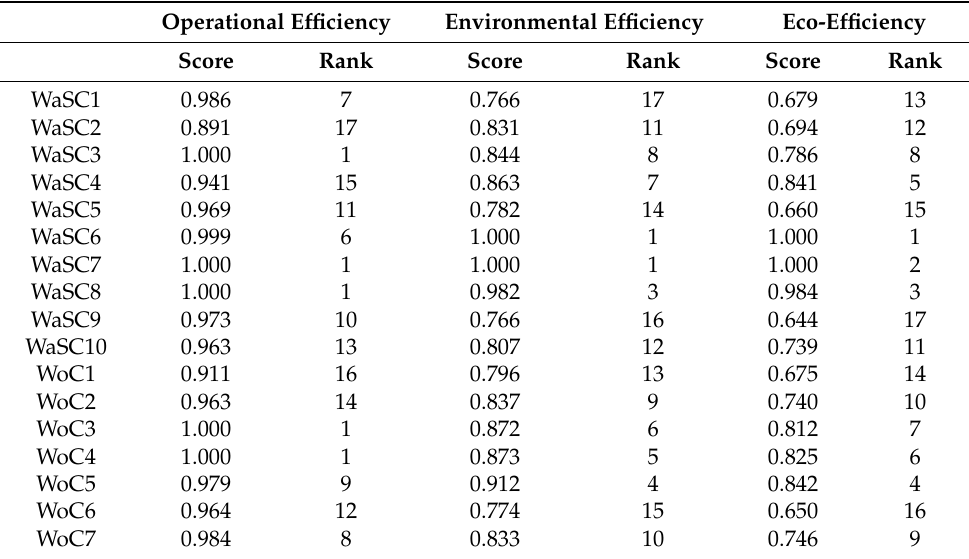
Table 3. Average operational efficiency (OE), environmental efficiency (EE) and eco-efficiency (ECOE) and ranking of English and Welsh water companies.